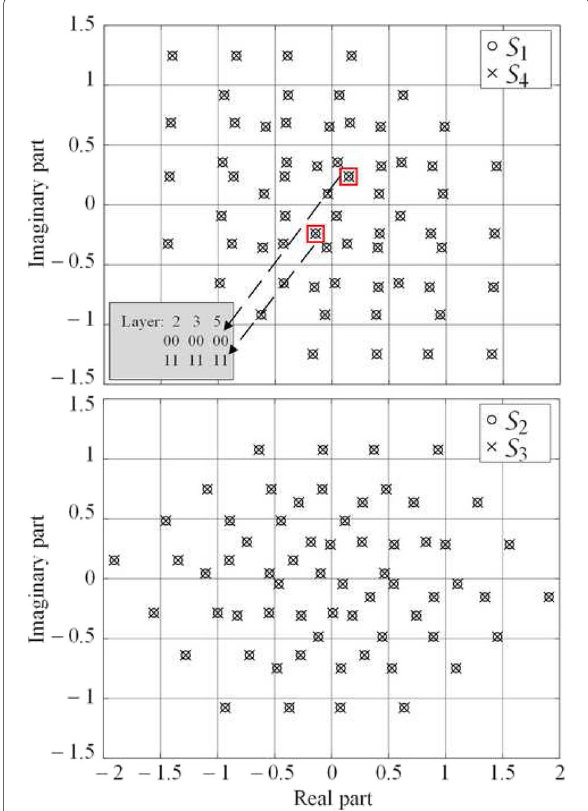
Fig. 7 Alphabets formed by all values of s